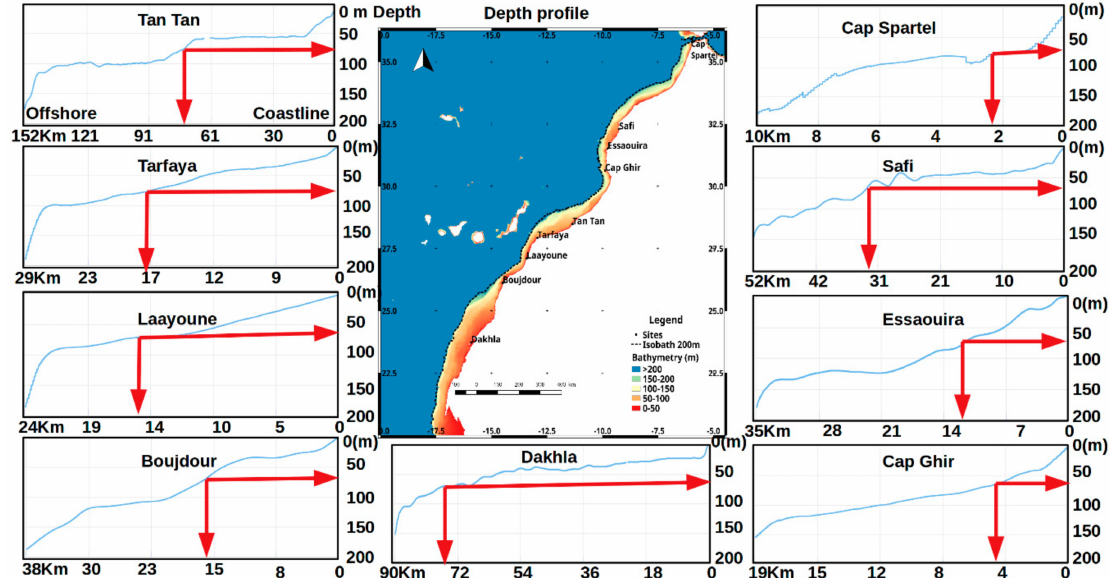
Figure 13. Depth profiles of the different sites from the shoreline to the offshore 200 m isobath limit. The red arrows point at the shallowest waters and the distance at which they are found. The depth delimitation at 60 m [37,38] was used to distinguish the possible floating technology resource from the likely reasonable upper economic limit of fixed- bottom